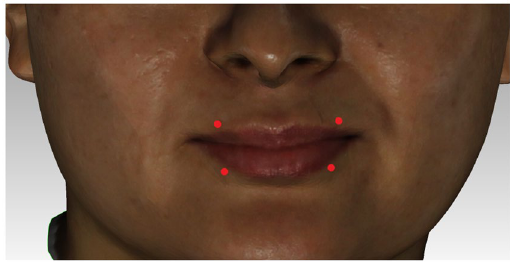
Figure 3. Schematic diagram of injection